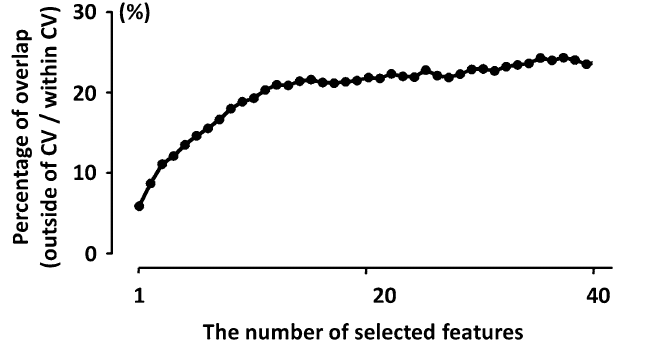
Figure 5. Mean overlap ratios (unit: %) between two feature selection approaches as a function of the number of selected